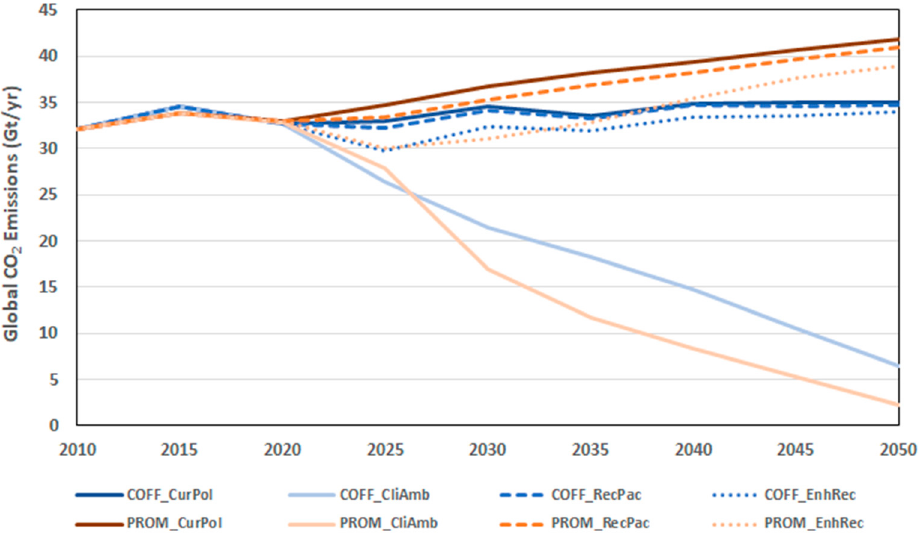
Figure 1. Global CO 2 emissions pathway over 2010–2050.